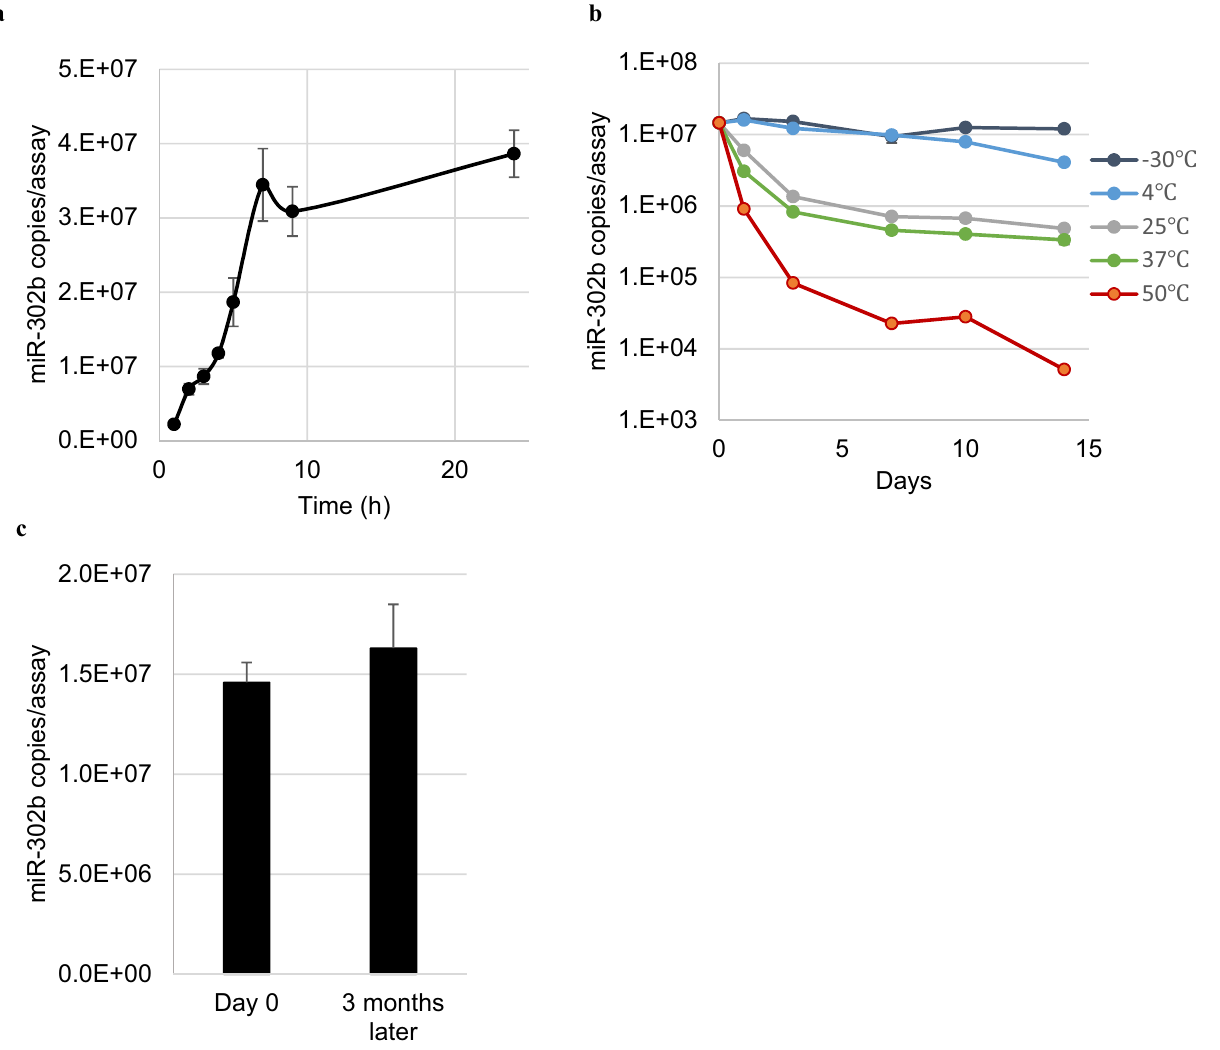
Figure 4. miRNAs in the culture supernatant were found to be stable. ( a ) Changes in the level of miR-302b in the culture supernatant observed up to 24 h after changing the medium. The graph shows data from three independent experiments. ( b ) The collected culture medium was stored at various temperatures for 2 weeks, and the change in the level of miR-302b was noted. Day 0 is the day of collection of the culture medium. ( c ) When the collected medium was stored at − 80 °C, the level of miR-302b detected before and that after 3 months of storage were comparable. Hence, − 80 °C was used in all further experiments. Error bar = +